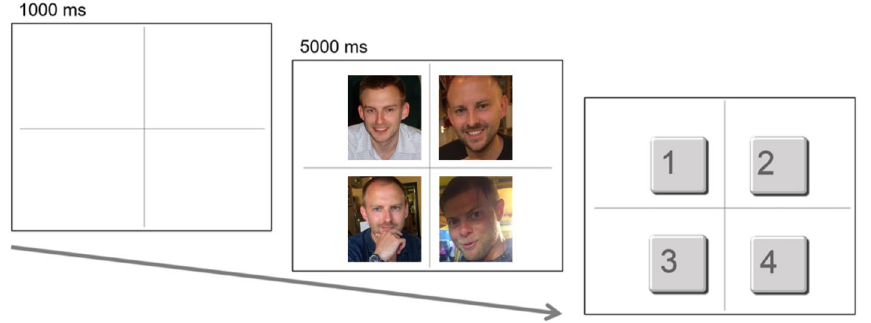
Figure 1. Schematic illustration of an experimental trial. The facial images shown in the figure were not used in the study, but are representative of the ambient images employed. The images shown are owned by the authors. The individuals depicted have given informed consent for the open-access publication of the